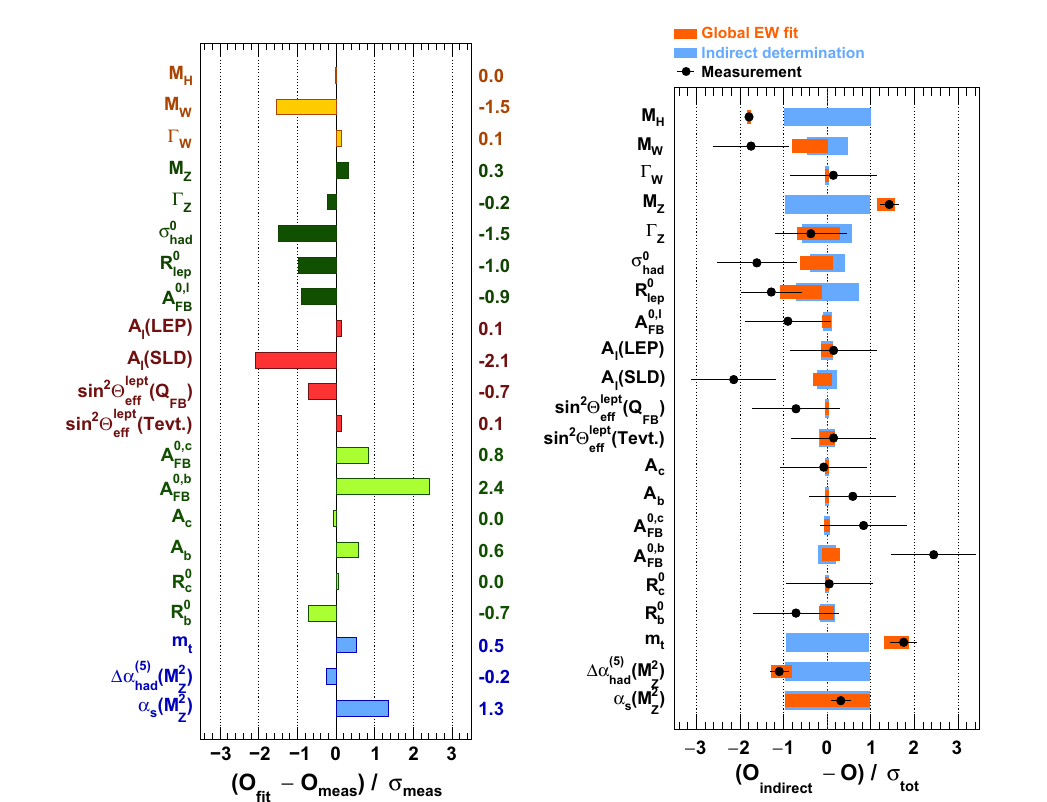
Fig. 3 Left: comparison of the fit results with the input measurements in units of the experimental uncertainties. Right: comparison of the fit results and the input measurements with the indirect determinations in unitsofthetotaluncertainties.Analogresultsfortheindirectdetermina-